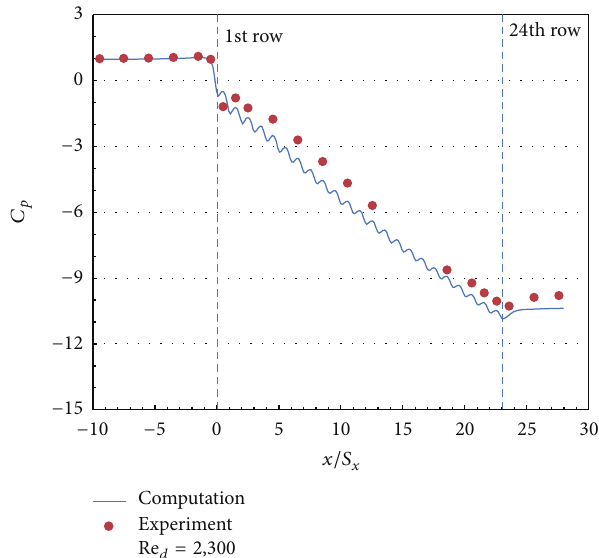
Figure 3: The pressure drop along with the tapping line. Compu- tation of normalized pressure drop along with the lower edge line of Figure 2(b) with COMSOL, which is compared with the experi- mental result, courtesy to Professor Tongbeum Kim, University of the Witwatersrand, South